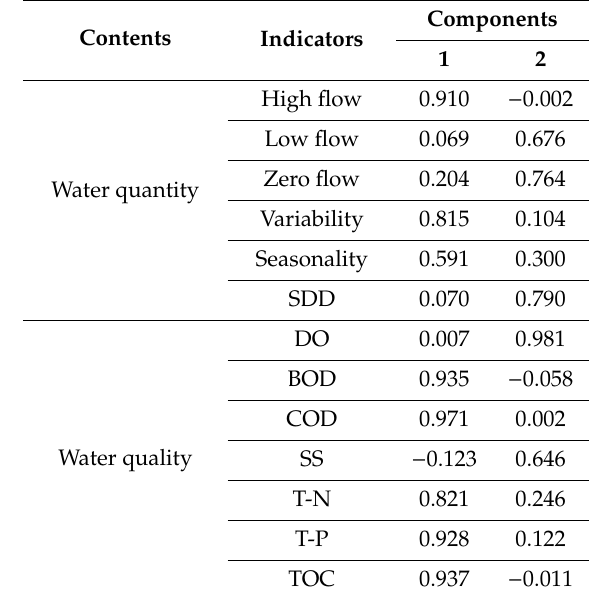
Table 13. The results of the rotated component matrix of water quantity and water